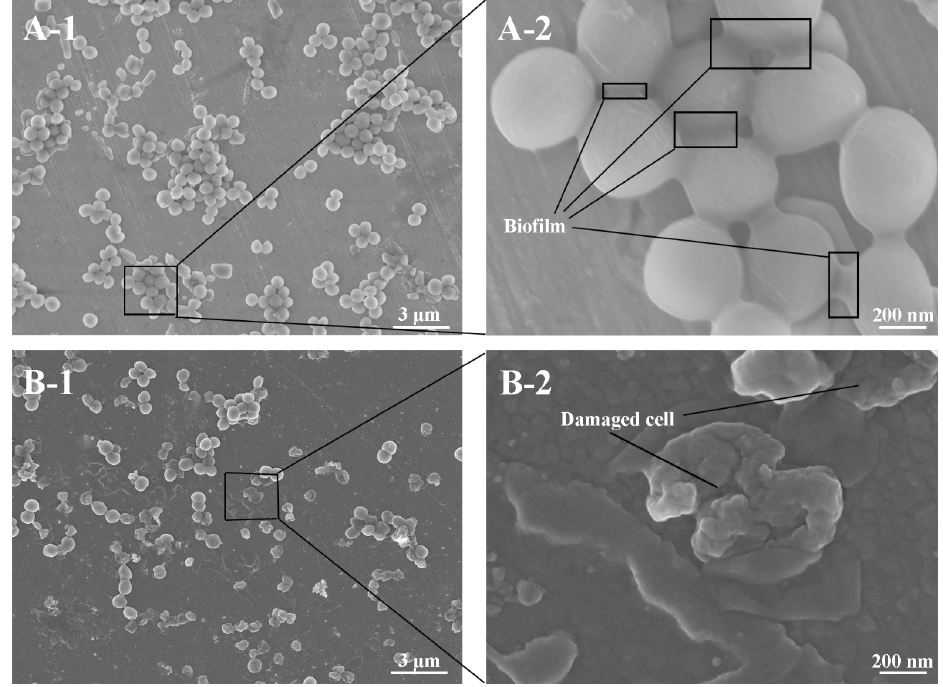
Figure 7. Field emission scanning electron microscopy (FESEM) images of bacteria adhesion on untreated ( A ) and P3 treated samples ( B ).